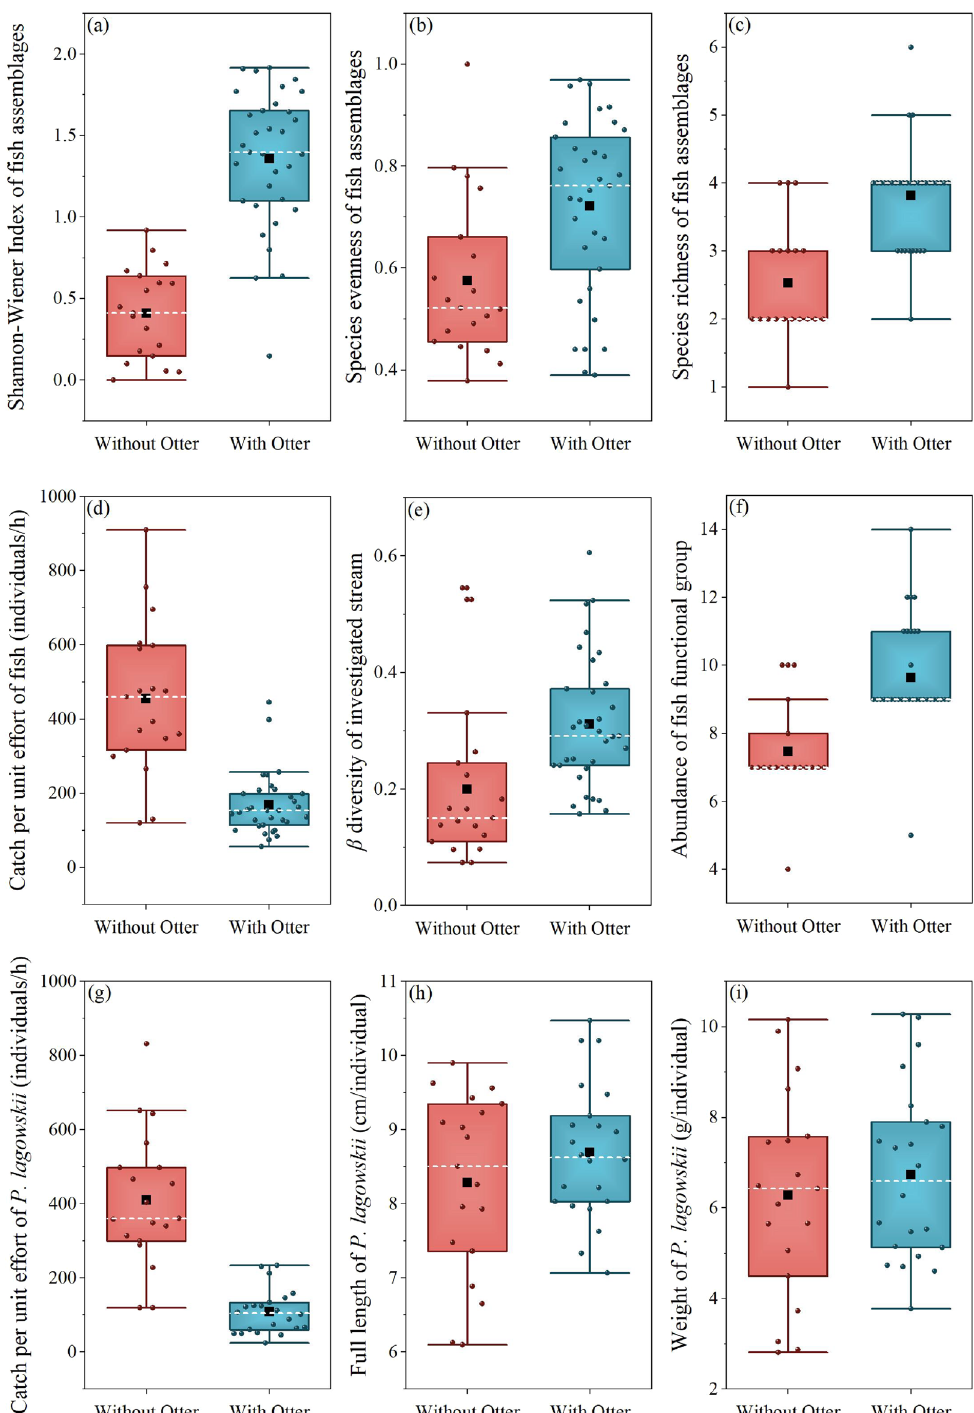
Figure 2. Box whisker plots of the diversity of fish assemblages in the presence and absence of L. lutra . Each picture shows the difference in fish assemblages with or without L. lutra . The white dotted line is median and the black square is the mean. The deviation bars represent the 5th and 95th